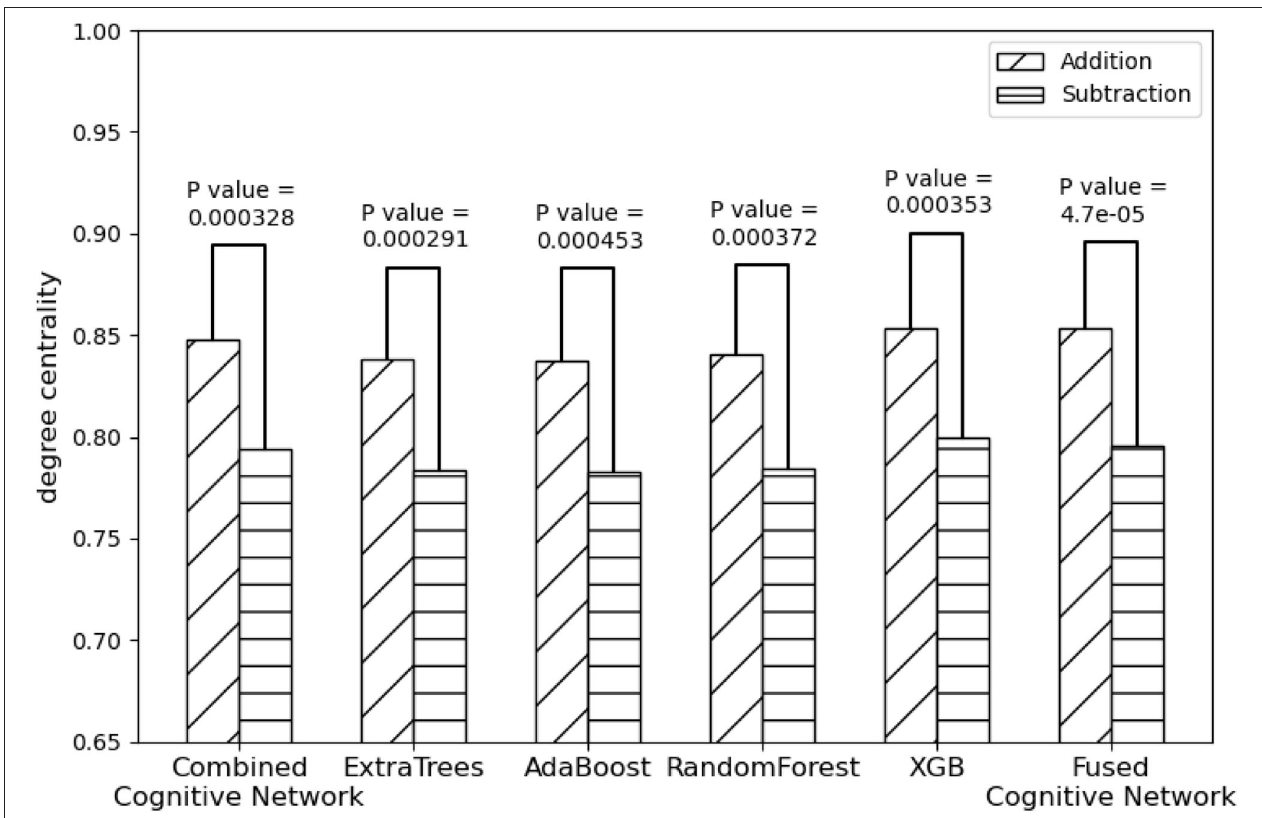
FIGURE 9 | Statistical comparison results of the FPNs’ topological properties between the addition cognitive state and the subtraction cognitive state. Among them, the fused FPN by the cognitive networks fusion algorithm has yielded the sharp differences with the biggest statistical significance between the two cognitive states of mental arithmetic, followed by the FPNs generated by ExtraTrees, CCN (Combined Cognitive Network), XGB, RandomForest, and